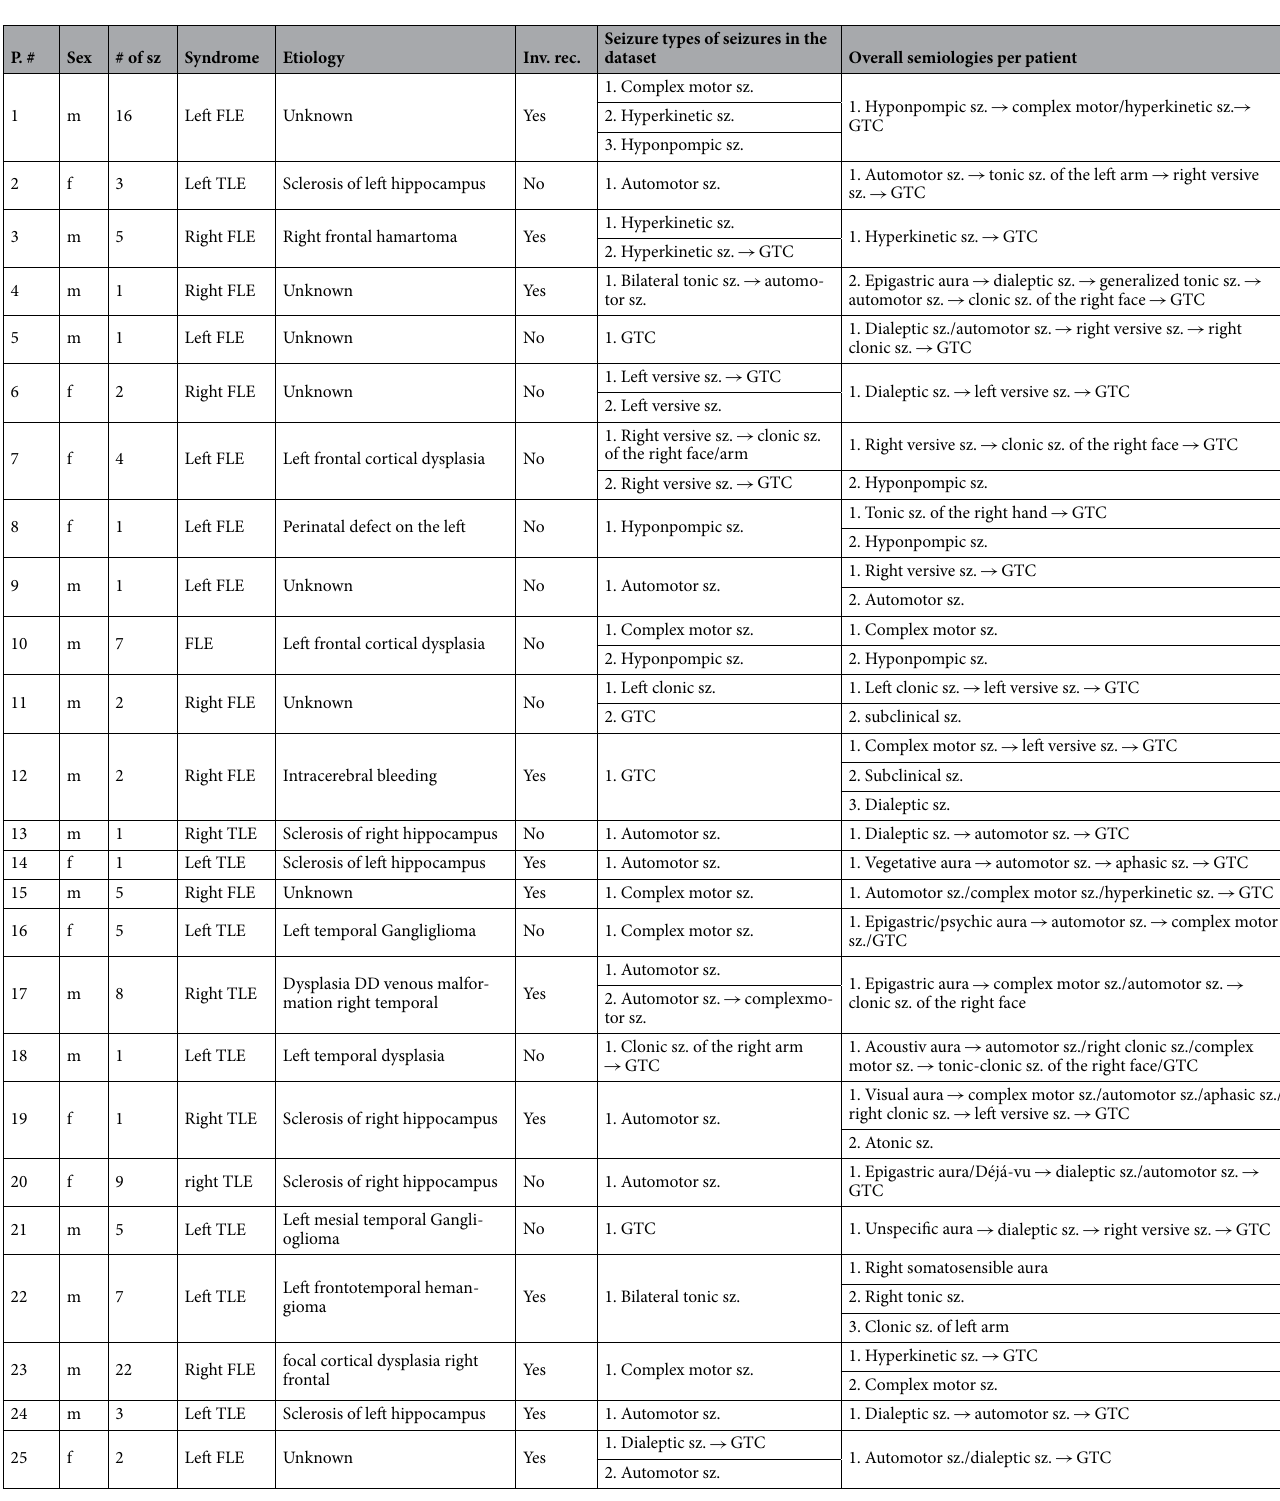
Table 4. Detailed clinical information of the patients and seizures in the dataset. (P. # - Patient Id; # of sz - Number of used seizures, Inv. rec. - Recordings with invasive Electrodes; f - female, m - male, sz. -